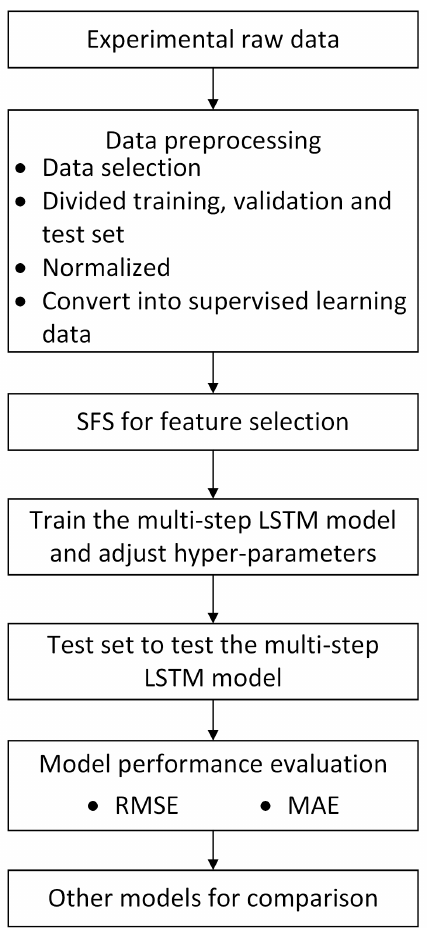
Figure 6. Flow chart of multi-step LSTM model for SOFC system state